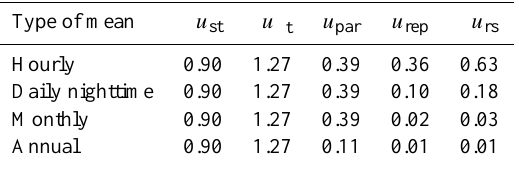
Table 3. Mean values of the uncertainty components (in nmolmol − 1 ) for different averaging periods from 25 March 2009– 31 December 2011. The hourly means correspond to the nighttime period